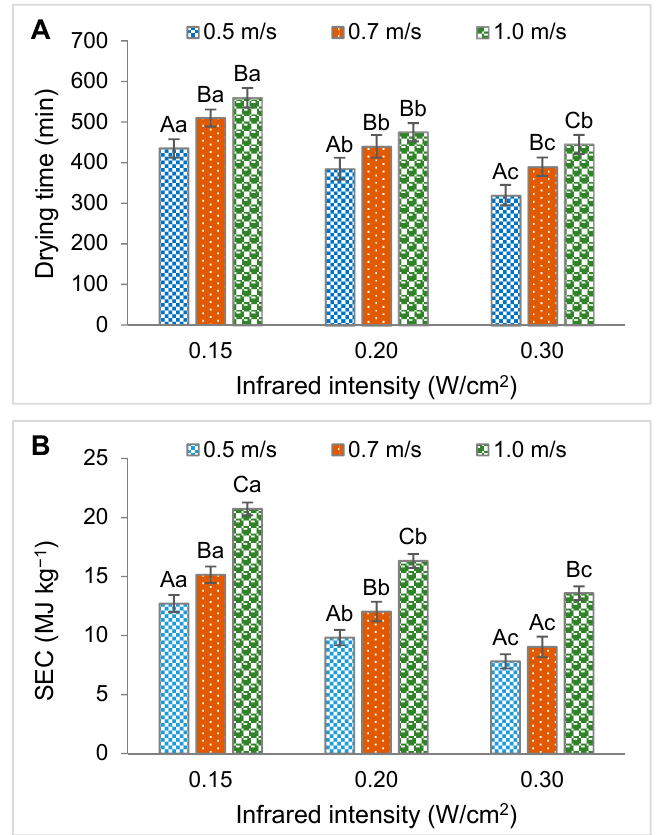
Figure 3. The effect of infrared radiation at different air velocities on the drying time ( A ) and specific Figure 3. The e ff ect of infrared radiation at di ff erent air velocities on the drying time ( A ) and specific energy consumption (SEC, B ). The different capital letters at the same infrared intensity showed energy consumption (SEC, B ). The di ff erent capital letters at the same infrared intensity showed significant differences, while different lowercase letters of the same series showed significant significant di ff erences, while di ff erent lowercase letters of the same series showed significant di ff erences differences (at P ≤ 0.05). (at P ≤